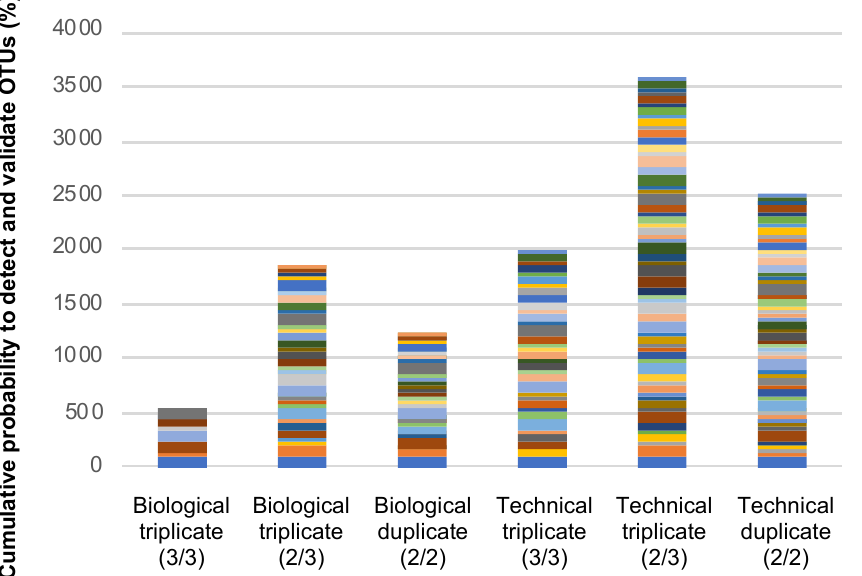
Figure 6. Efficiency of the epicPCR experiment expressed as the cumulative probability to detect OTUs of SXT/R391 hosts from the Meurthe River water. This figure considers each of the 67 validated OTUs mentioned in Figure 5 and Supplementary Tables S2 and S3 using either technical of biological replicates and, according to experimental plan presented in Figure 4. The ratios in brackets indicate the occurrence a given OTU must have between the considered replicates for being validated. Each color/band represents a given OTU.